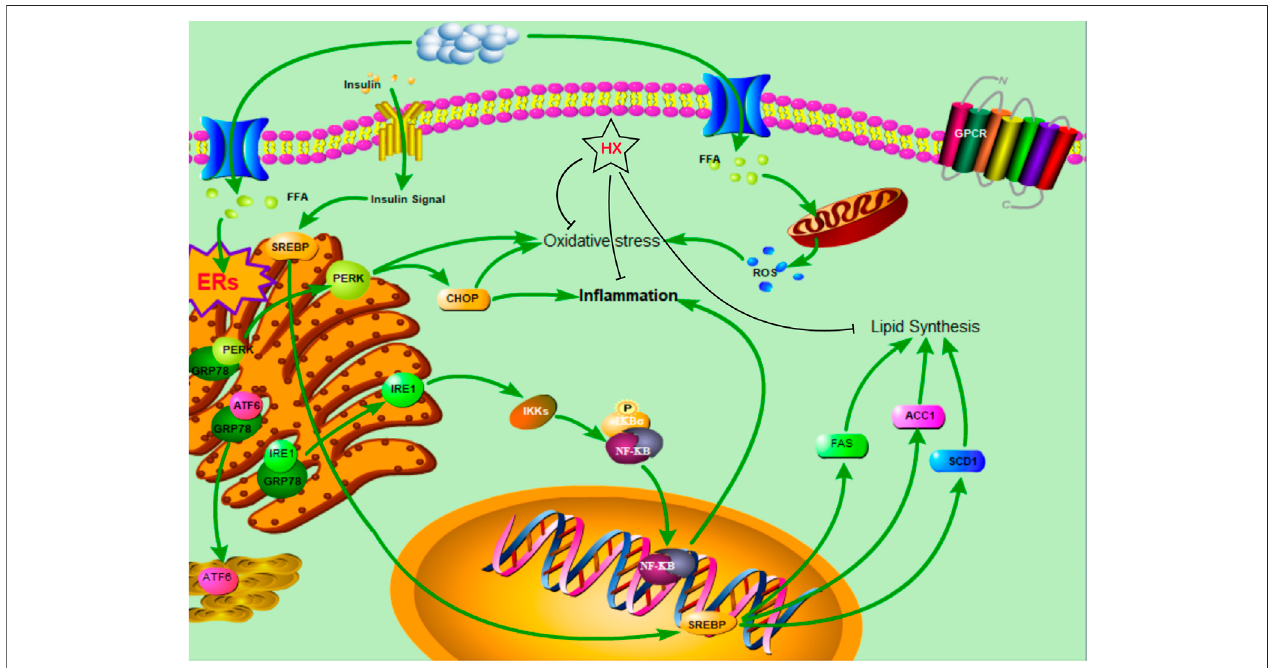
FIGURE 9 | The protective mechanism of a water extract of Huo Xiang (HX) on free fatty acid (FFA)-induced nonalcoholic fatty liver disease (NAFLD).